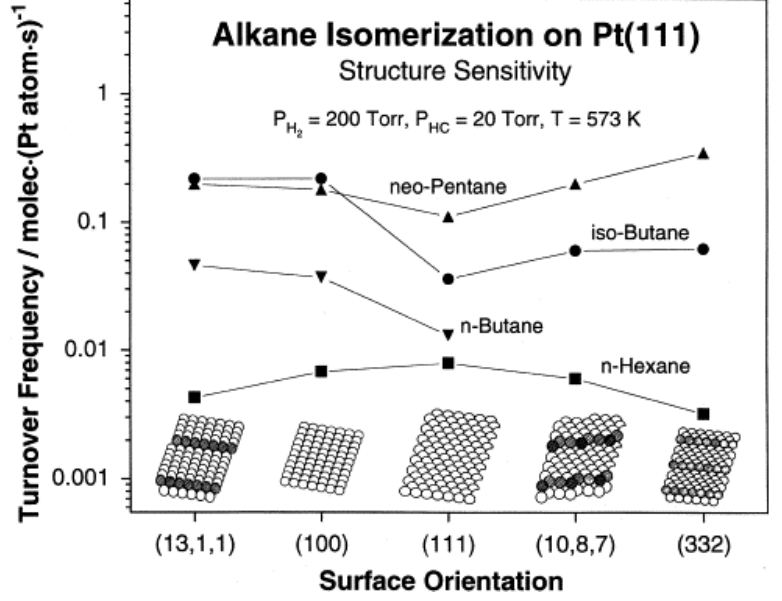
Figure 1. Structure sensitivity in alkane isomerization reactions catalyzed over platinum single-crystal surfaces. Adapted with permission from [28], Elsevier, 2001.